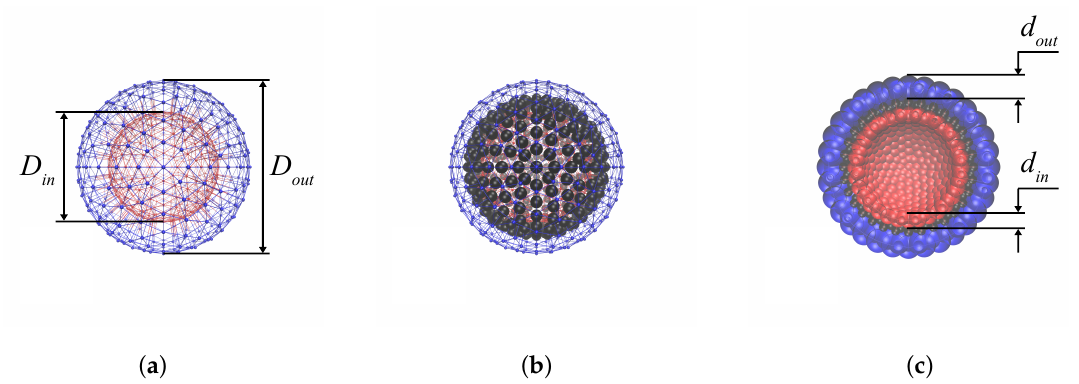
Figure 1. ( a ) outside view of the model MPS “skeleton”: a pair of concentric uniformly meshed spherical shells; ( b ) the same as in ( a ) but the inter-membrane space is filled with solid monodisperse magnetic particles; ( c ) cross-section of the model where the nodes are transformed in finite-size blobs, thus confining the magnetic